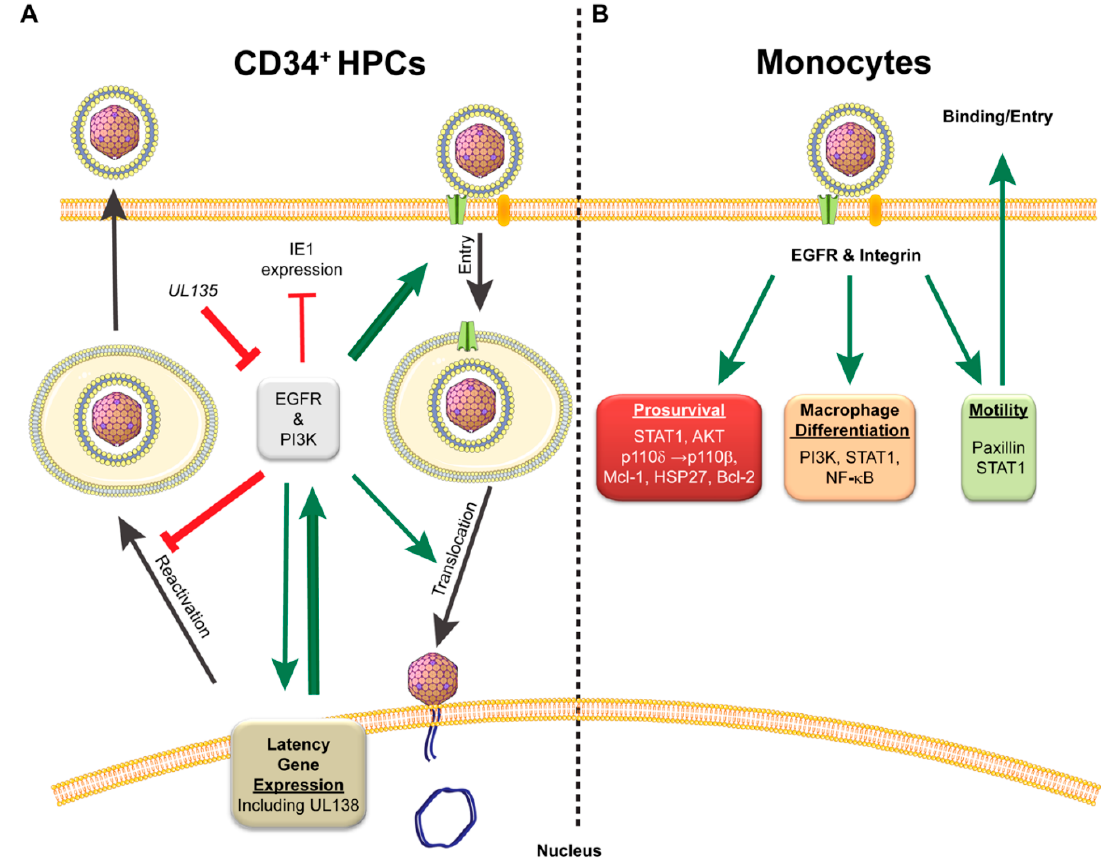
Figure 2. Importance of epidermal growth factor receptor (EGFR) and integrin signaling during CMV latent infection. ( A ) EGFR signaling is important for CMV entry, translocation to the nucleus, and to establish latency. Attenuation of EGFR signaling by the UL135 proteins or inhibitors disrupts this pattern and contributes to reactivation of CMV replication. Thickness of arrows and lines depicts strength of supporting studies; ( B ) In monocytes, CMV binding and entry via EGFR and integrin receptors results in changes in signaling to promote cellular survival, macrophage differentiation, and motility to promote virus dissemination in the infected host. Red T bars indicate inhibition. Green arrows indicate activation.